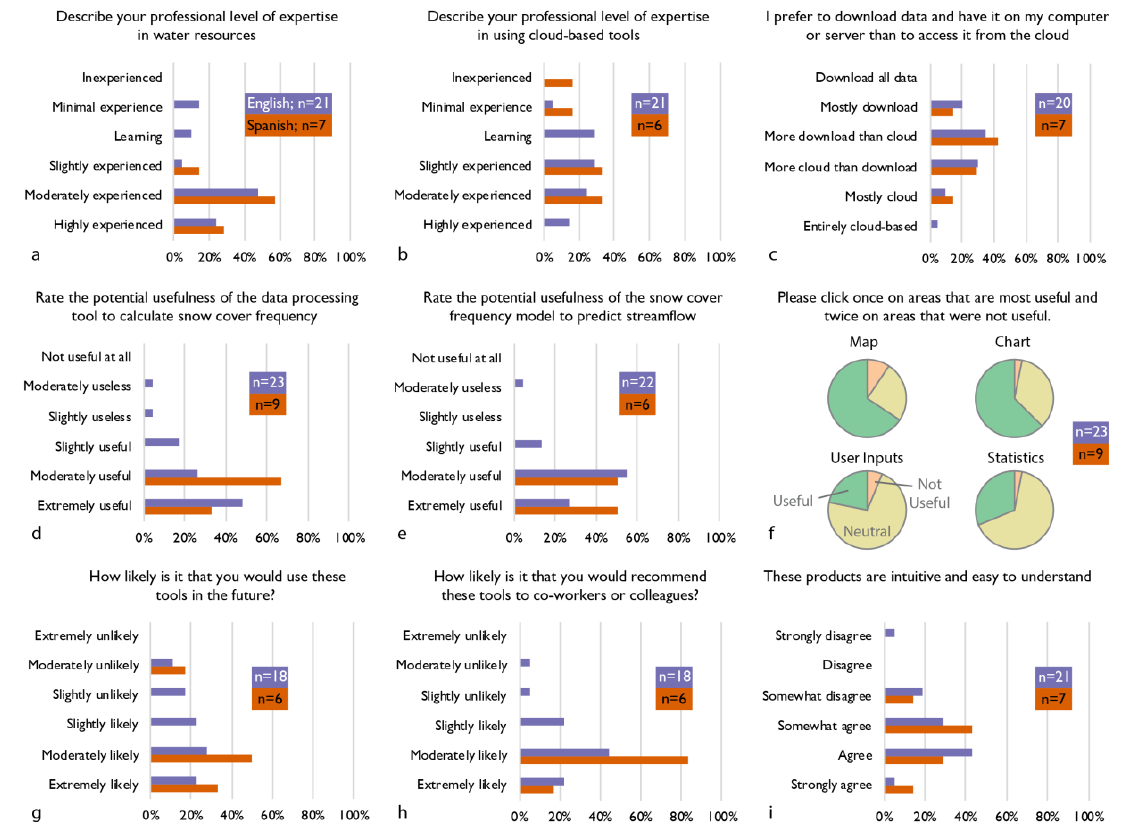
Figure 4. The questions and responses ( a – j ) from the qualitative assessments completed by participants. Each question provided to the participants is above its respective sub-figure. In all sub-figures the number of responses (n) are represented in purple for English-speaking participants and orange for Spanish-speaking participants.